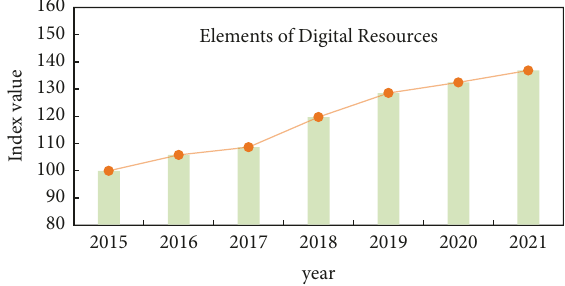
Figure 5: Evaluation results of digital resource